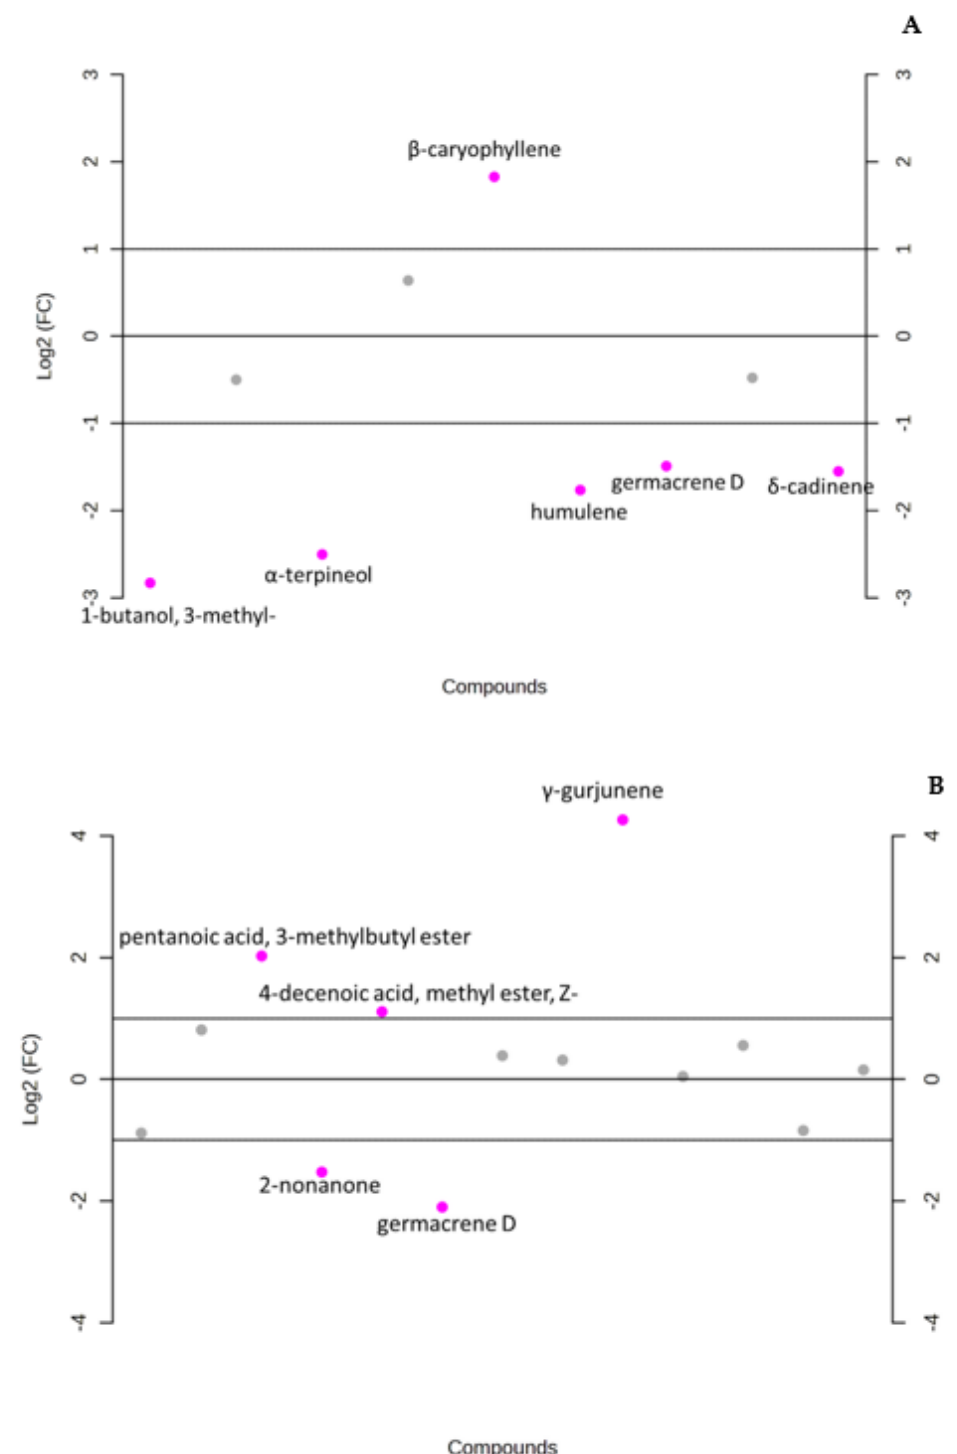
Figure 2. ( A ) Fold change of powdered/unpowered fresh leaves. The circle with Log2(FC) > 0, representing the feature above the threshold, is upregulated in powdered fresh leaves; the circles with Log2(FC) < 0 represent the metabolites downregulated in powdered fresh leaves; ( B ) fold change of powdered/unpowdered fresh inflorescences.